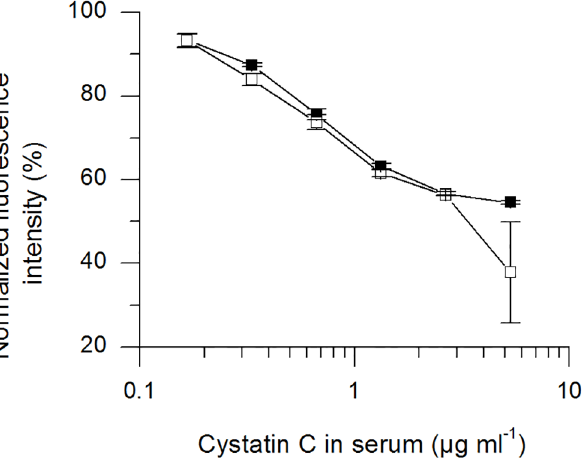
Fig 11. Replacement assay with serially-diluted reference material. Serial dilutions of reference material in dNHuS were used to replace GFP-hCC. The hCC concentration in serum ( μ g/ml) is plotted against the fluorescence readout. A logarithmic scale was used on the x-axis. The assay was carried out twice, represented by black circles and white